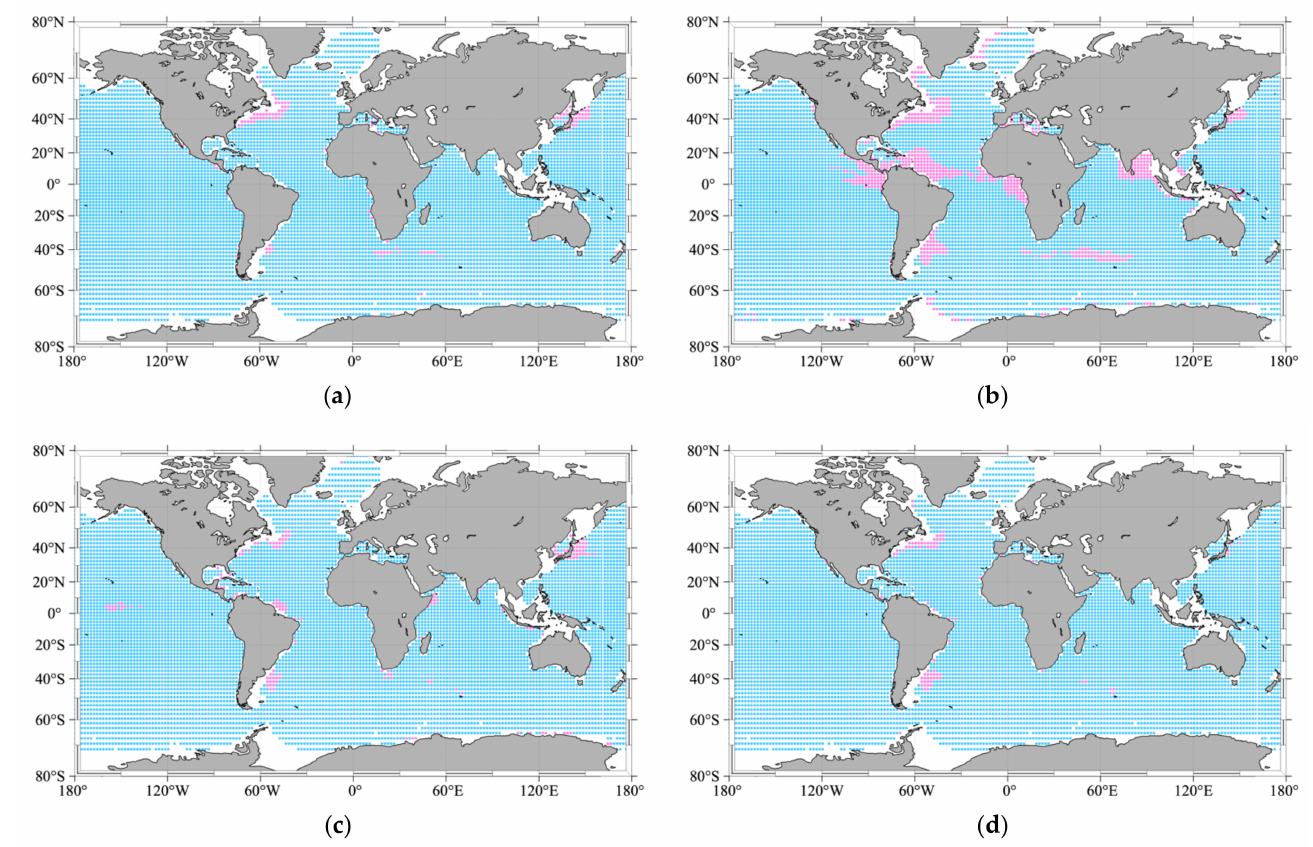
Figure 6. Results of the confidence interval test at a confidence of 0.05: ( a ) temperature estimations at the sea surface; ( b ) salinity estimations at the sea surface; ( c ) temperature estimations at a depth of 150 m; ( d ) salinity estimations at a depth of 150 m. The blue dots indicate credible gridded point whose results were within the given confidence interval. The red dots represent the